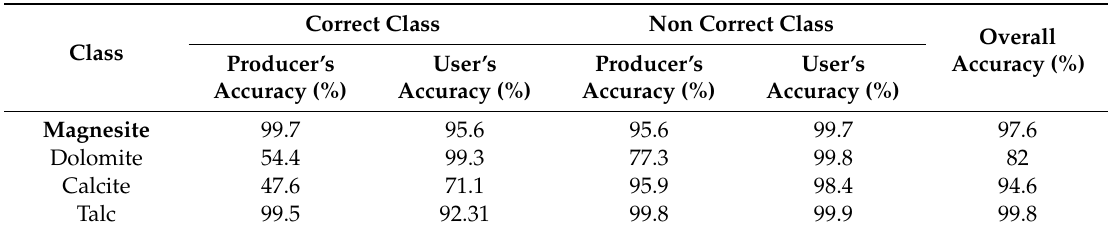
Table 10. A confusion matrix for the classification results of the validation set from the binary regression